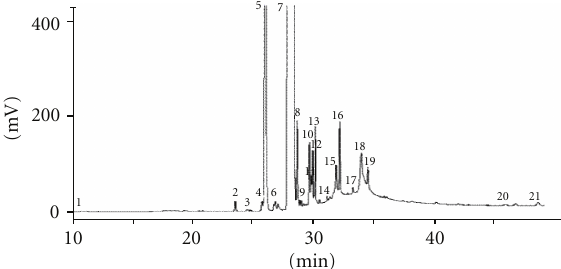
F 1: B100 Biodiesel chromatographic